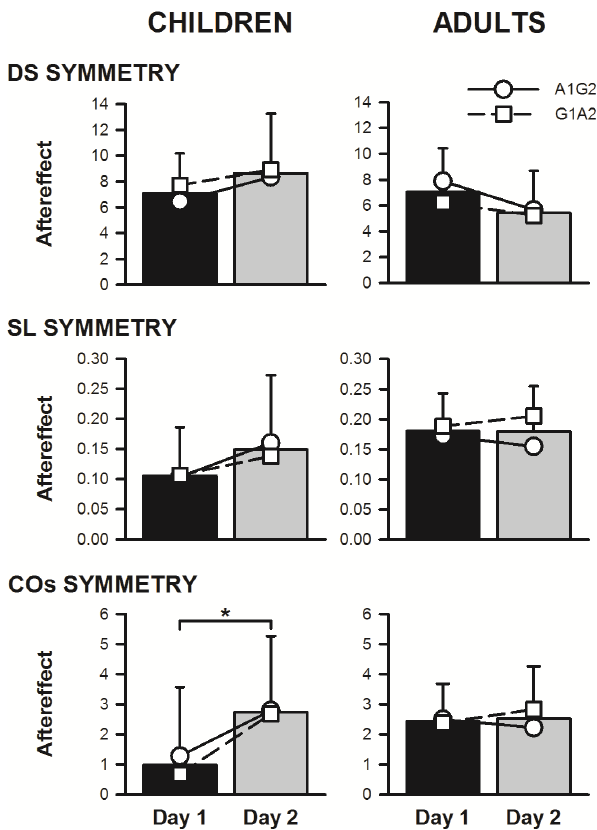
Figure 4. Experiment 1: Children, but not adults, may show greater learning on Day 2. Mean aftereffects for the two exposure sequences: abrupt 1 st , gradual 2 nd (A1G2, circles joined by solid line), and gradual 1 st , abrupt 2 nd (G1A2, squares joined by dashed line) are shown superimposed on the overall mean (bar graph) collapsed across the perturbation type. DS – double support; SL – step length; COs – centre of oscillation. Children showed a significantly larger aftereffect of COs on Day 2 (asterisk), whereas there were no statistical differences between Day 1 and Day 2 for adults. Error bars: 1 SD.